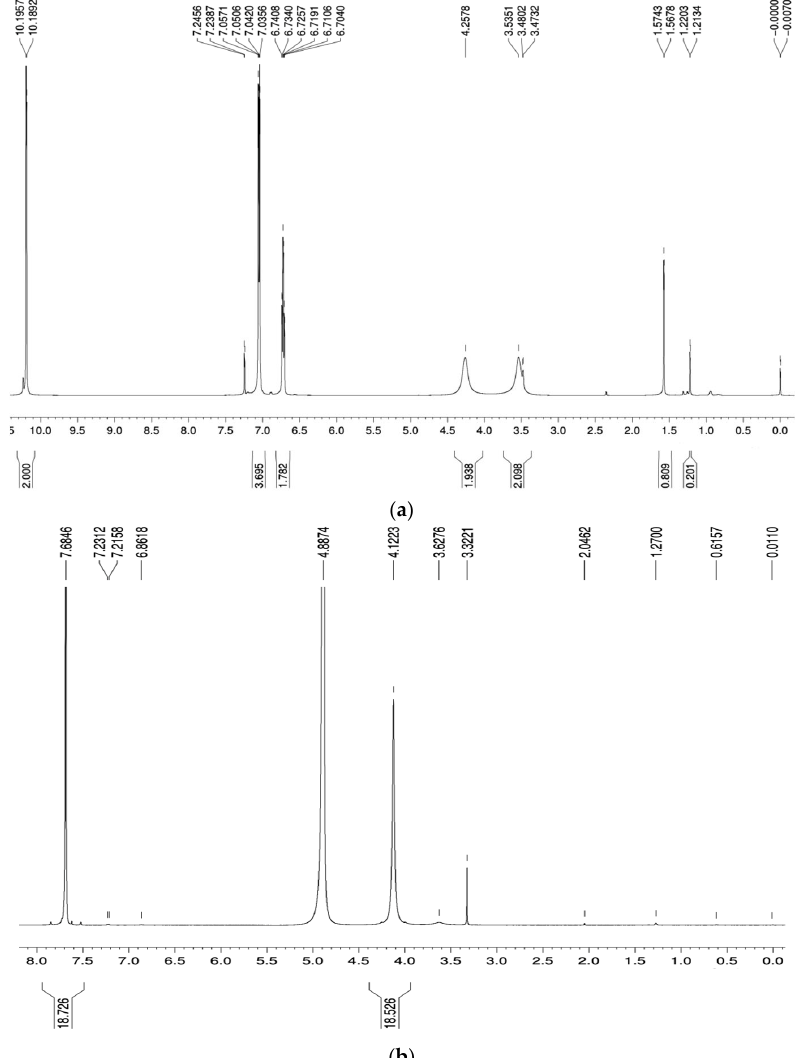
Figure 2. 1 H ‐ NMR spectrum of ( a ) calix[4]arene and ( b ) SCX4. Figure 2. 1 H-NMR spectrum of ( a ) calix[4]arene and ( b ) SCX4. Calix[4]arene ( 1 ) was then used as the next starting material for p ‐ (b) sulfonatocalix[4]arene ( 2 ) by treating the compound with concentrated H 2 SO 4 to produce the desired product in 90% yield. The proton NMR chemical shift at δ 7.47 (Ar H, m, 8H) Figure 3. Non-aligned and bead-free smooth fibers were achieved by a fine optimization shows the para ‐ substituted benzene rings, while the carbon attached to the sulfonate peak is indicated at δ 135.7 ppm. Compound 2 also has a cone conformation as indicated by the 1 HNMR spectrum, with the characteristic methylene bridge proton peaks at δ 3.32 and 4.12 ppm (Figure 2). This data is in agreement with the 13 C ‐ NMR methylene bridge peak at δ 30.5 ppm.